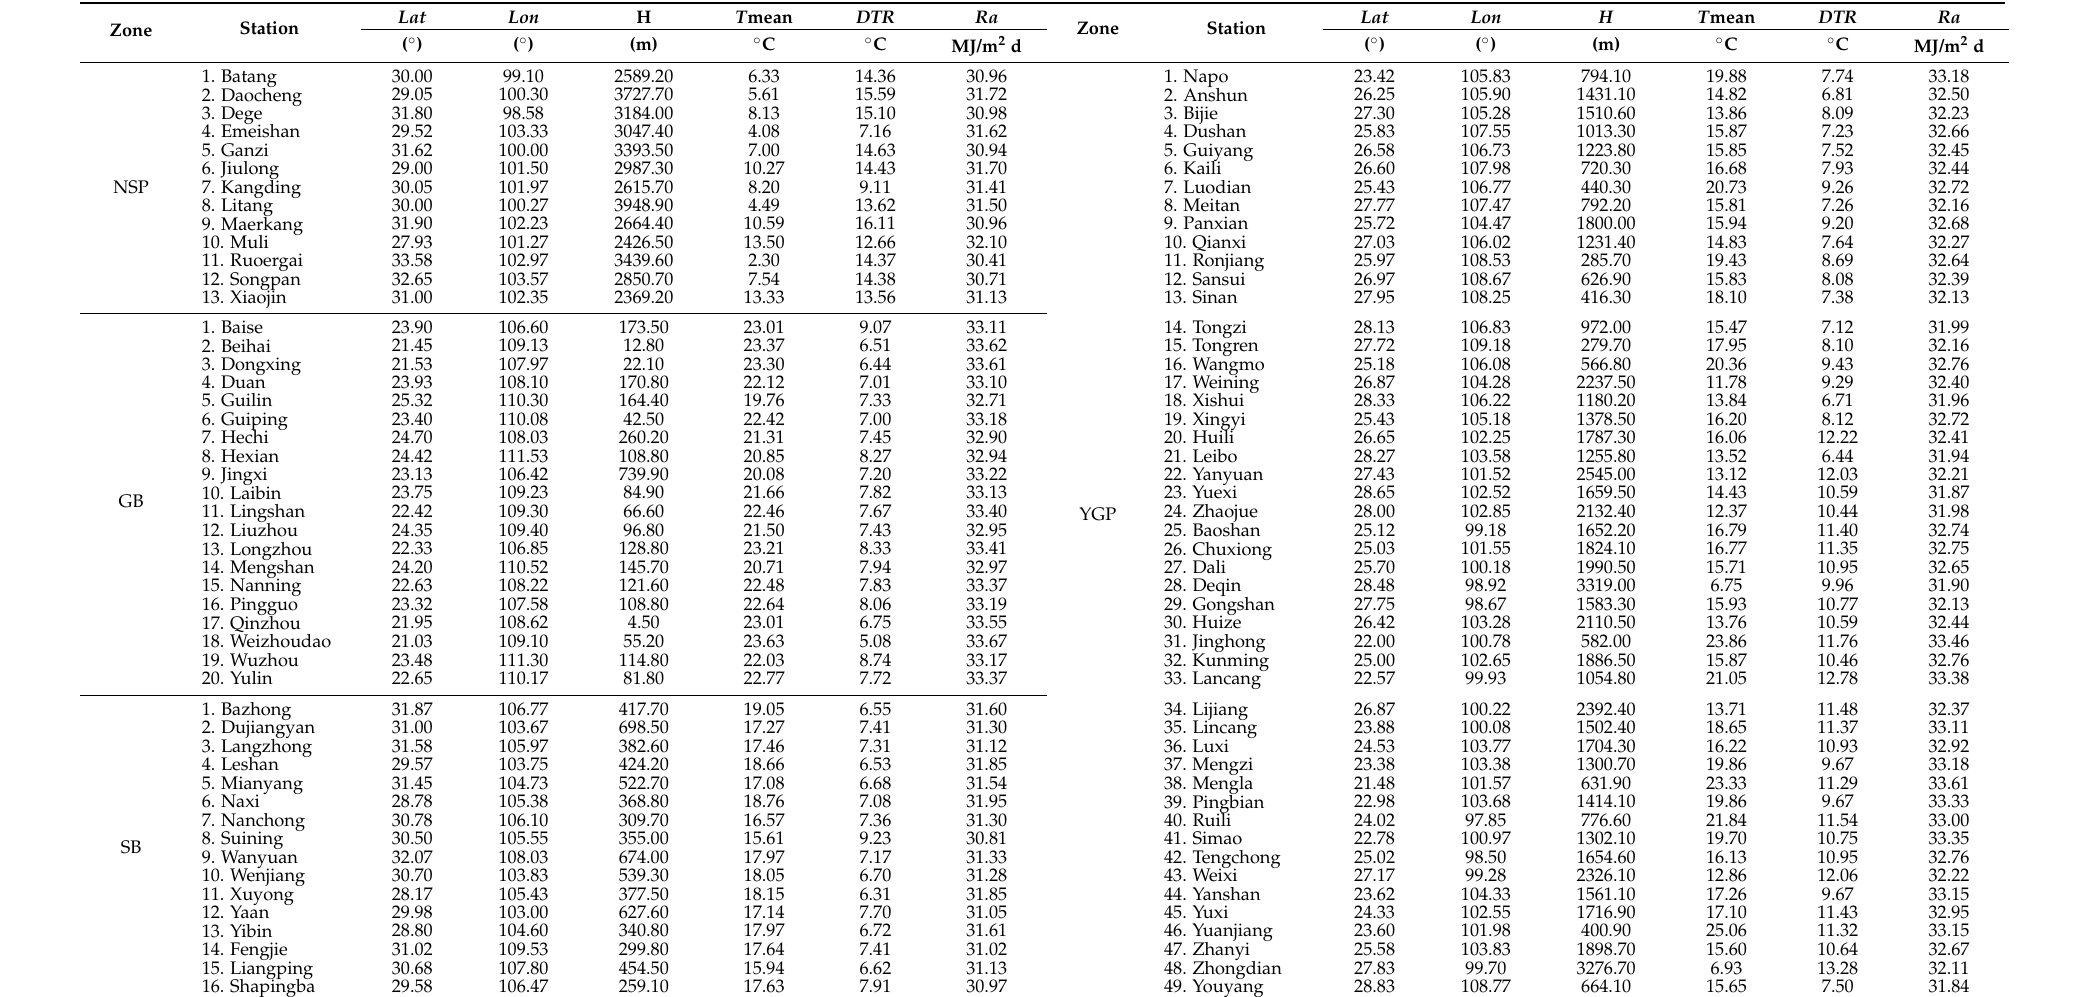
Table 1. Mean values of the main climate variables of meteorological stations in Southwest China from 1961 to